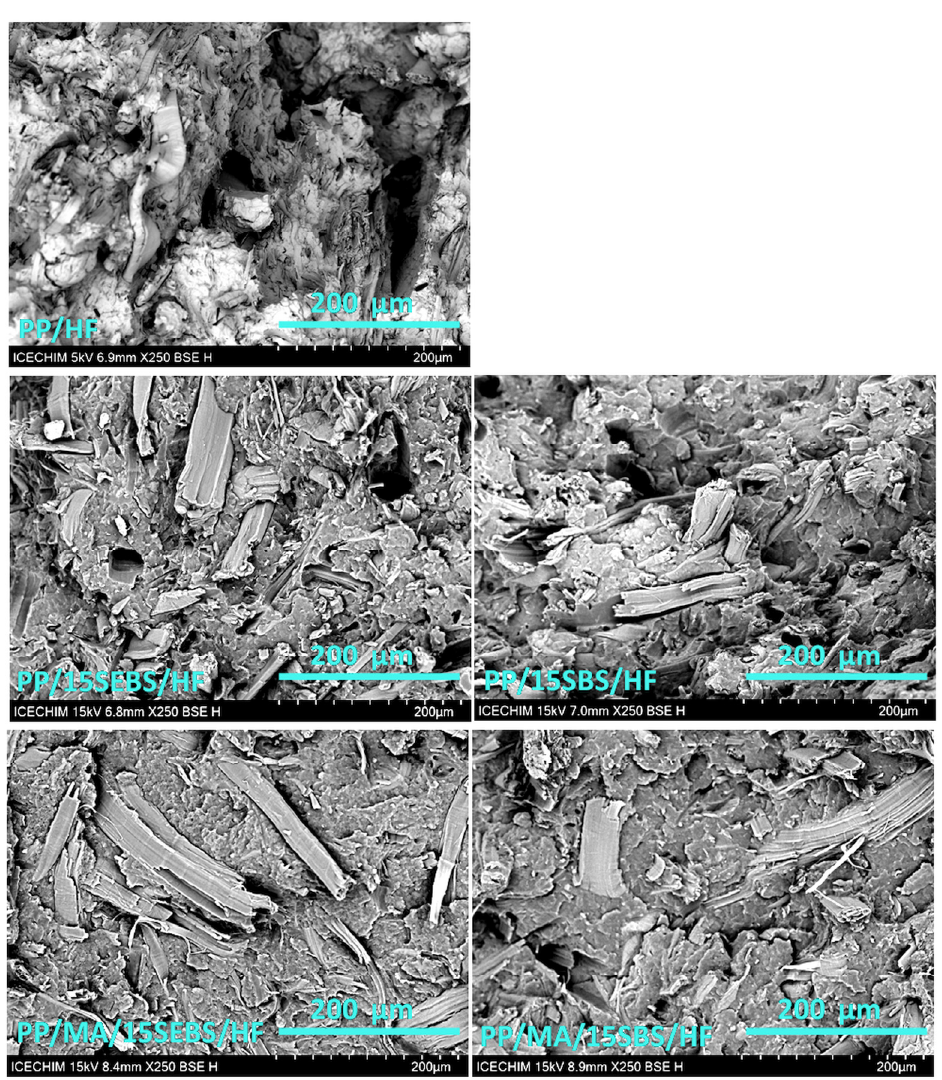
Figure 5. SEM images of fractured surfaces of composites (×250).